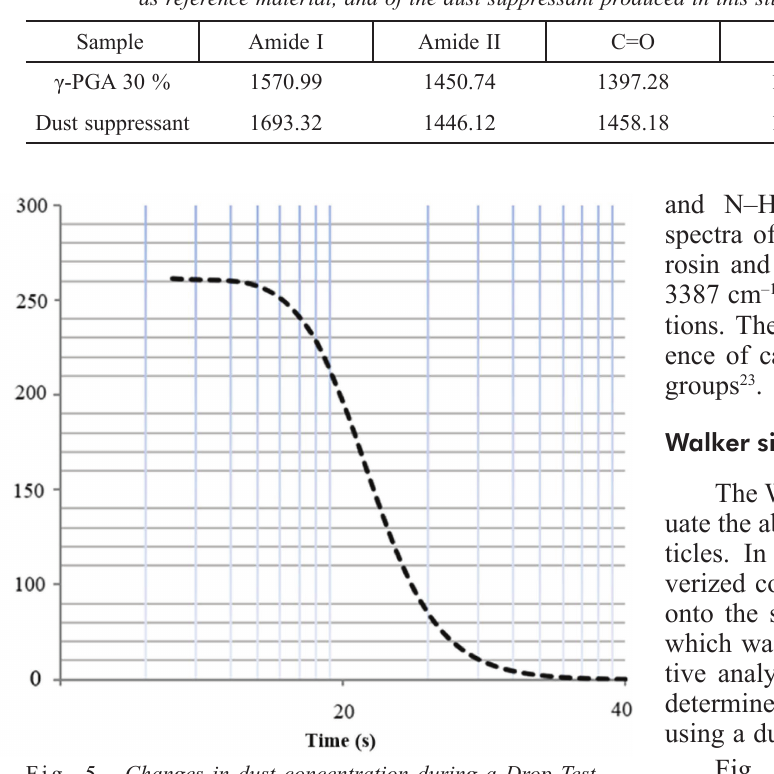
Fig. 5 – Changes in dust concentration during a Drop Test, using the plant-based dust suppressant